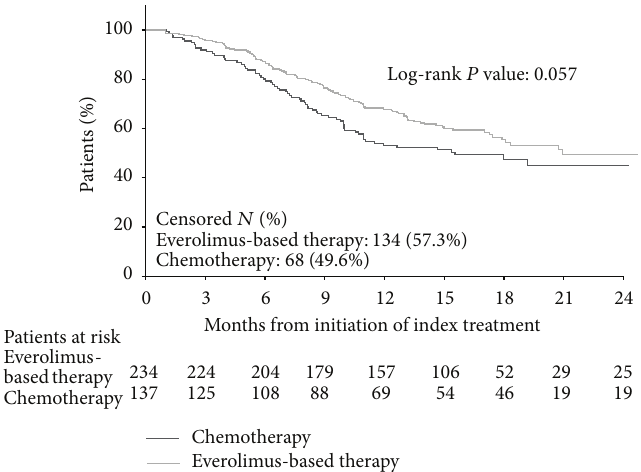
Figure 3: Comparison of progression-free survival between everolimus-based therapy and